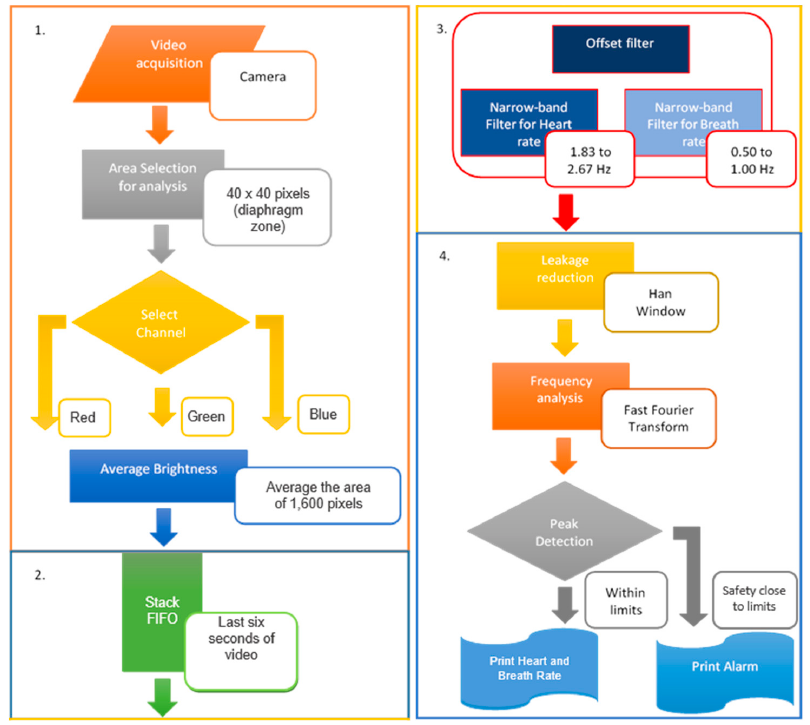
Figure 1. Sequence used for measurement of heartbeat and